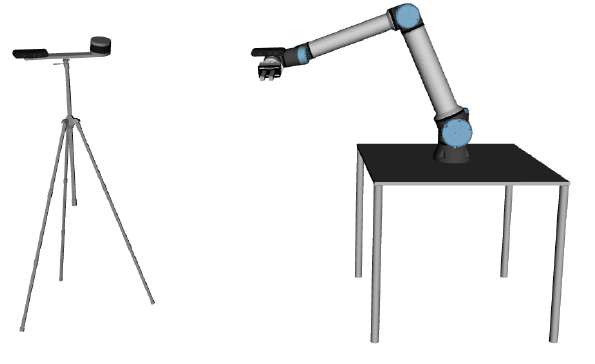
Figure 5. The Multi-Modal Test roBot (MMTBot), a simulated robotic system containing, from left to right in the figure: an RGB camera and a 3D LiDAR mounted on a tripod, and a second RGB camera assembled on the end effector of a robotic manipulator